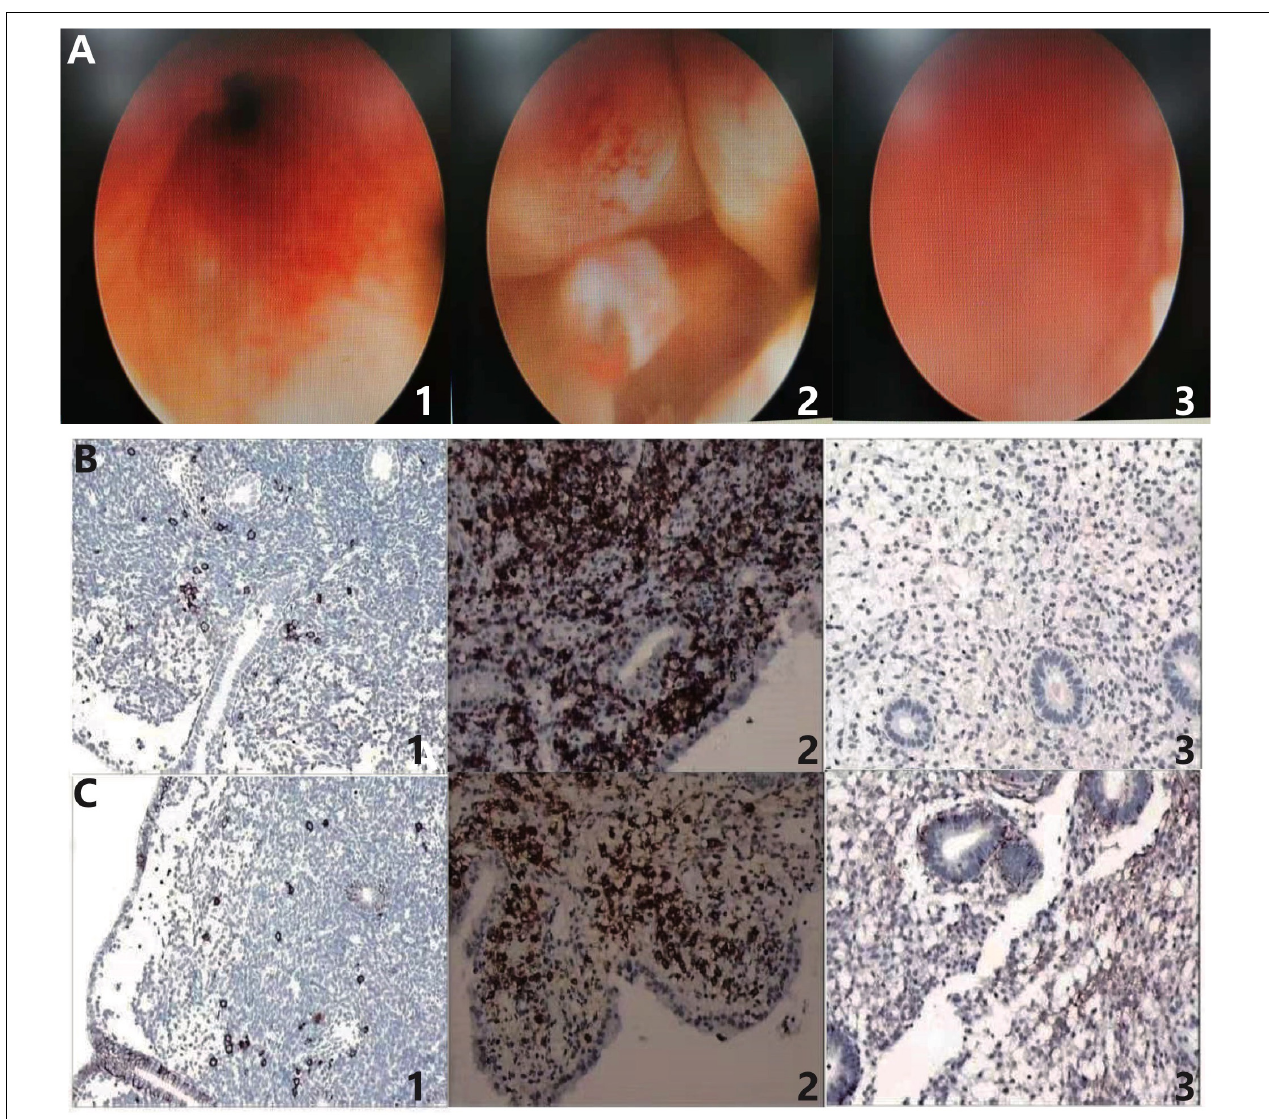
FIGURE 2 | Hysteroscopy and immunohistochemical identification of plasma cells in the diagnosis of chronic endometritis. (A 1 ) Hyperemia and (A 2 ) micro-polyps represent the presence of inflammation in endometrium of CE patients. (A 3 ) Negative control of non-CE patients without inflammatory endometrium. (B 1 ) CD38 (+, > 5–18/HPF) and (B 2 ) CD38 (+, > 20/HPF) indicate the presence of plasma cells in the endometrium of CE patients. (B 3 ) CD38 (–) suggests the absence of plasma cell in non-CE patients. (C 1 ) CD138 (+, > 20/HPF) and (C 2 ) CD138 (+, > 20/HPF) also indicate the presence of plasma cells in CE patients. (C 3 ) CD138 (–) was the negative control in non-CE patients. CE means chronic endometritis. HPF means high-power